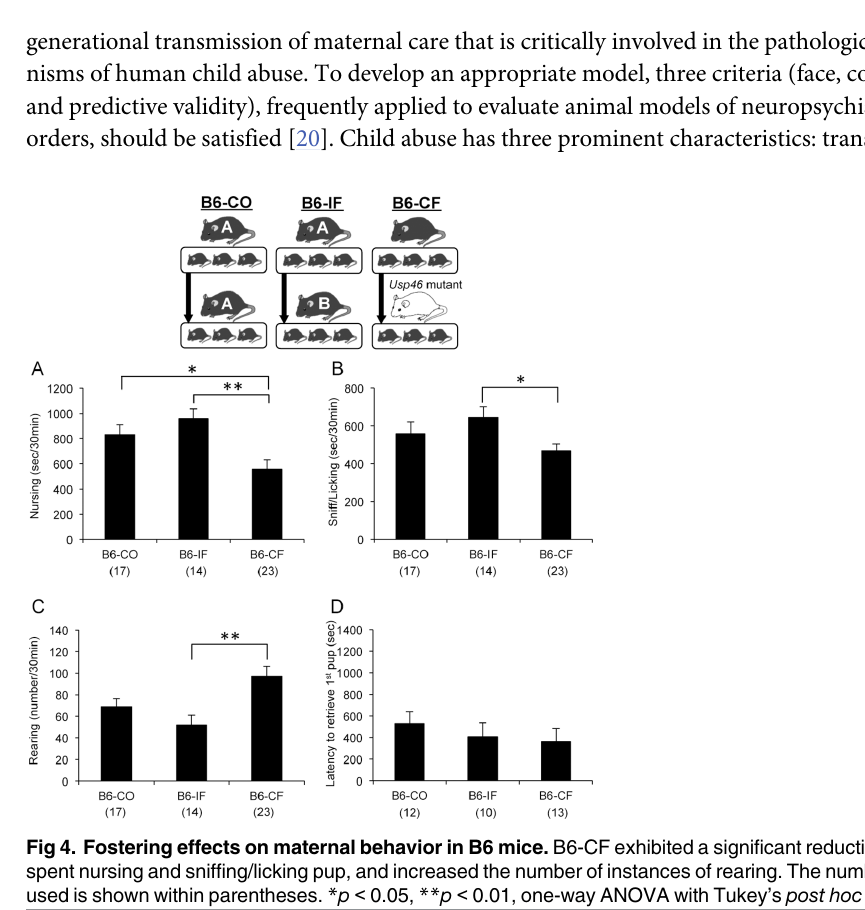
Fig 3. Maternal behaviors post parturition. Maternal behaviors (arched-back nursing, nursing in prone position and licking/grooming) were observed for 3 days following parturition. The ratio of occurrence of these behaviors is shown as the percent of total observation time. The number of mice used is shown within parentheses. * p < 0.05, Mann-Whitney U test.